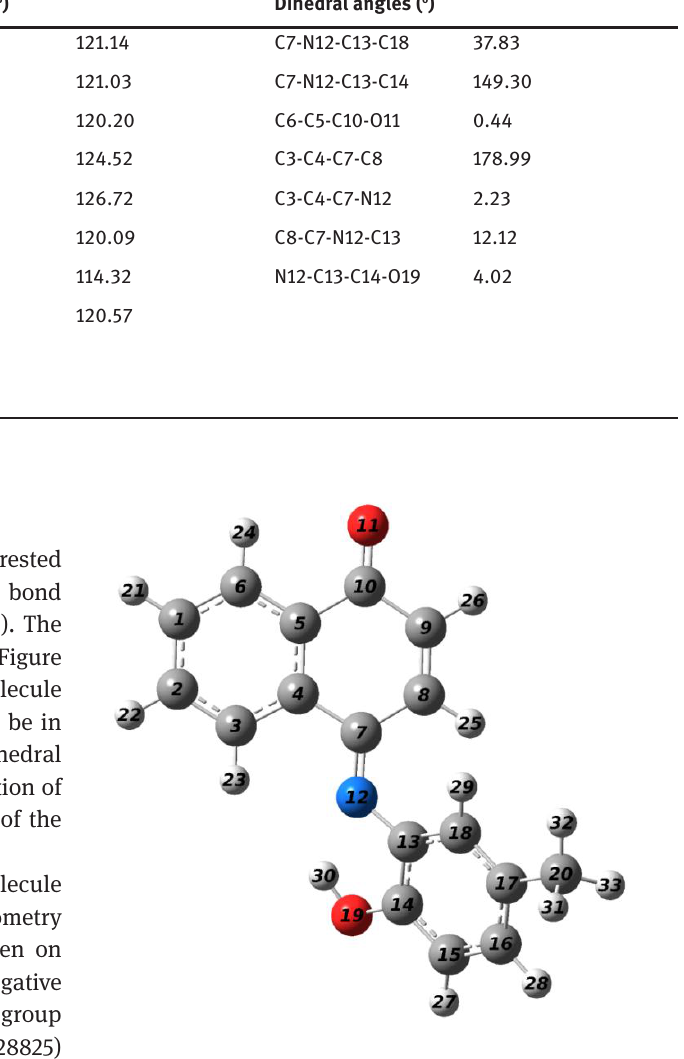
Figure 2: Optimized and numbered structure of PINQ molecule.